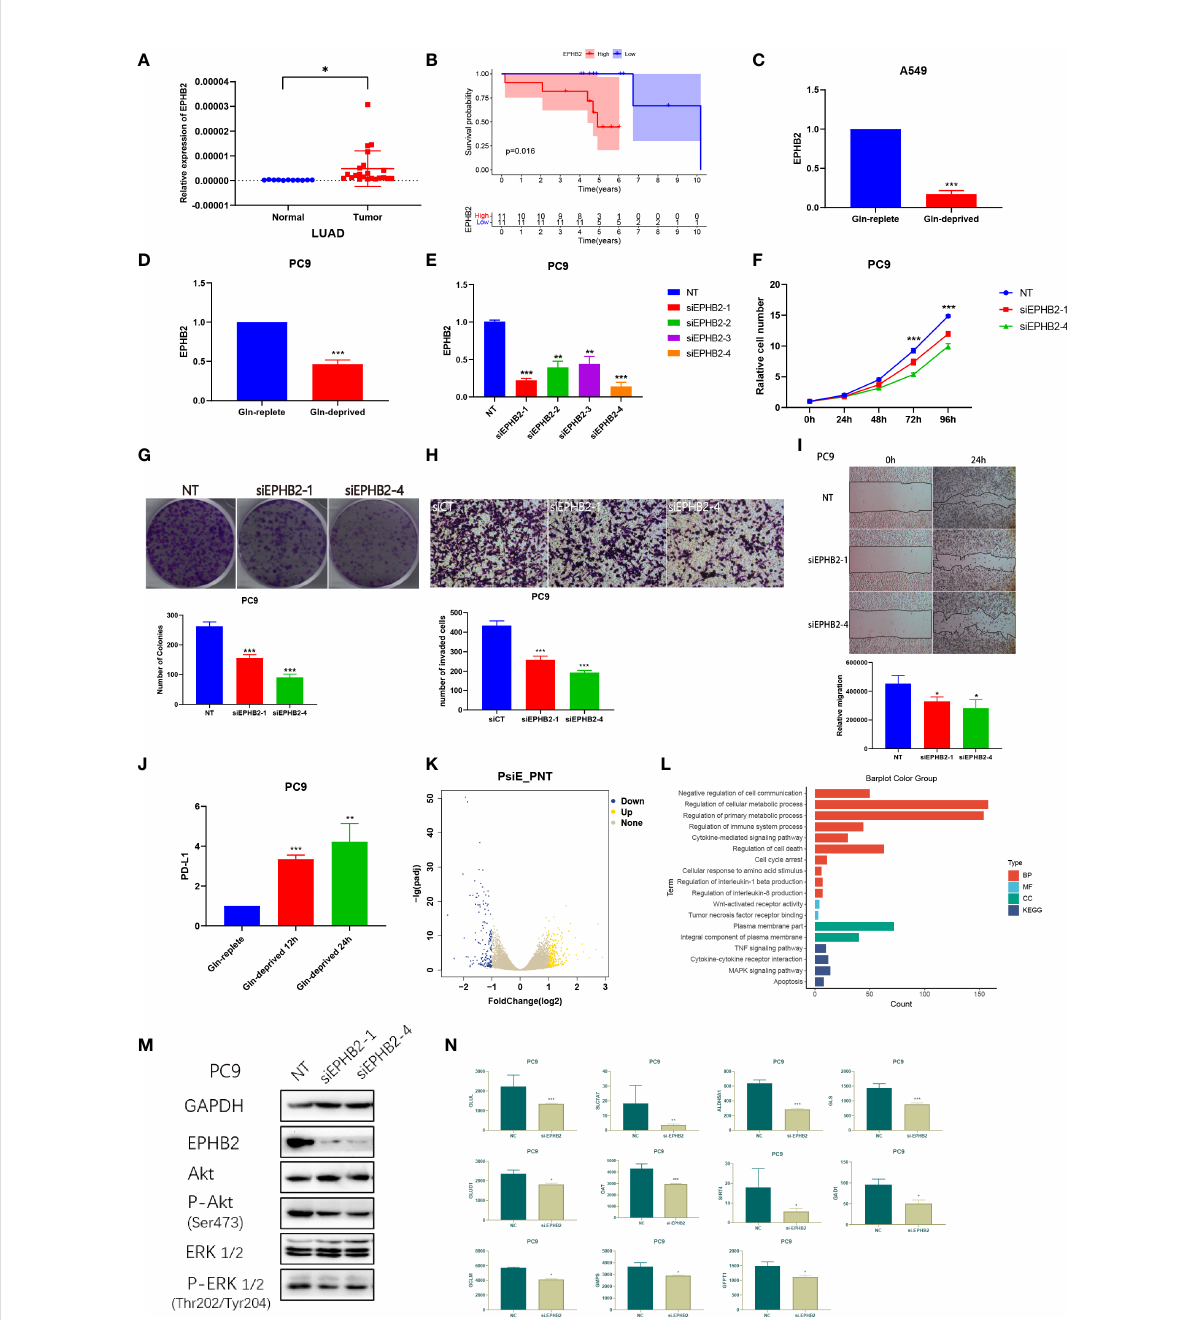
FIGURE 13 EPHB2 affects the biological behaviors of LUAD cells in vitro . (A) Expression of EPHB2 in normal and tumor specimens. (B) Survival analyses between low and high EPHB2 groups in LUAD cohorts. Expression of EPHB2 with treatment of Gln-replete and Gln-deprived in A549 cell line (C) and PC-9 cell line (D) . (E) QRT-PCR was performed to detect the ef fi ciency of EPHB2-siRNA transfection. (F) Growth curves of PC-9 cells treated with EPHB2 knockdown was developed using SRB assay. (G) Colony formation assay was conducted to detect the proliferation of PC-9 cells. (H) Transwell assay was performed to detect the invasion of PC-9 cells with treatment of EPHB2 knockdown. (I) The cell migration of EPHB2 knockdown was detected by wound healing assay in PC-9 cells. (J) Expression of PD-L1 with treatment of Gln-replete medium, Gln- deprived medium for 12h and Gln-deprived medium for 24h. (K) A volcano map to exhibit differential expressed genes between normal and EPHB2 knockdown treated PC-9 cells. (L) GO and KEGG enrichment analysis between normal and EPHB2 knockdown treated PC-9 cells after sequencing. (M) GAPDH, EPHB2, AKT, P-AKT (Ser473), ERK1/2, P-ERK1/2 (Thr202/Tyr204) were detected by western blotting in EPHB2 knockdown treated PC-9 cells. (N) Expression of key Gln metabolism regulators in normal and si-EPHB2 treated PC-9 cells. "* ” means that p < 0.05; “ ** ” means that p < 0.01; " “ *** ” means that p <